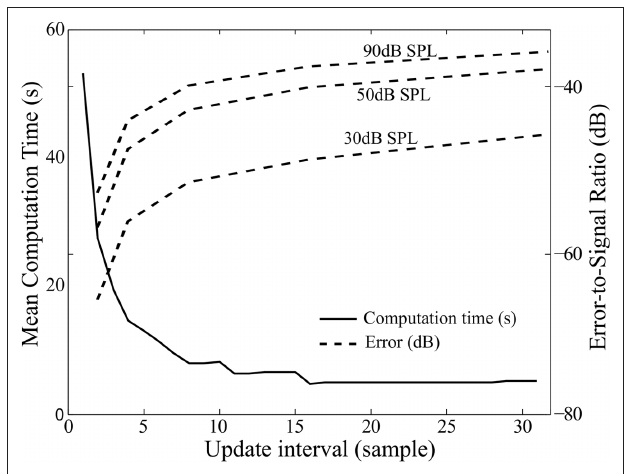
FiGUre 5 | Performance of the dynamic compressive gammachirp model (DCGC) as a function of update interval. Solid line, left axis: computation time; Dashed lines, right axis: error-to-signal ratio for sounds at three different levels (30, 50, and 90 dB).